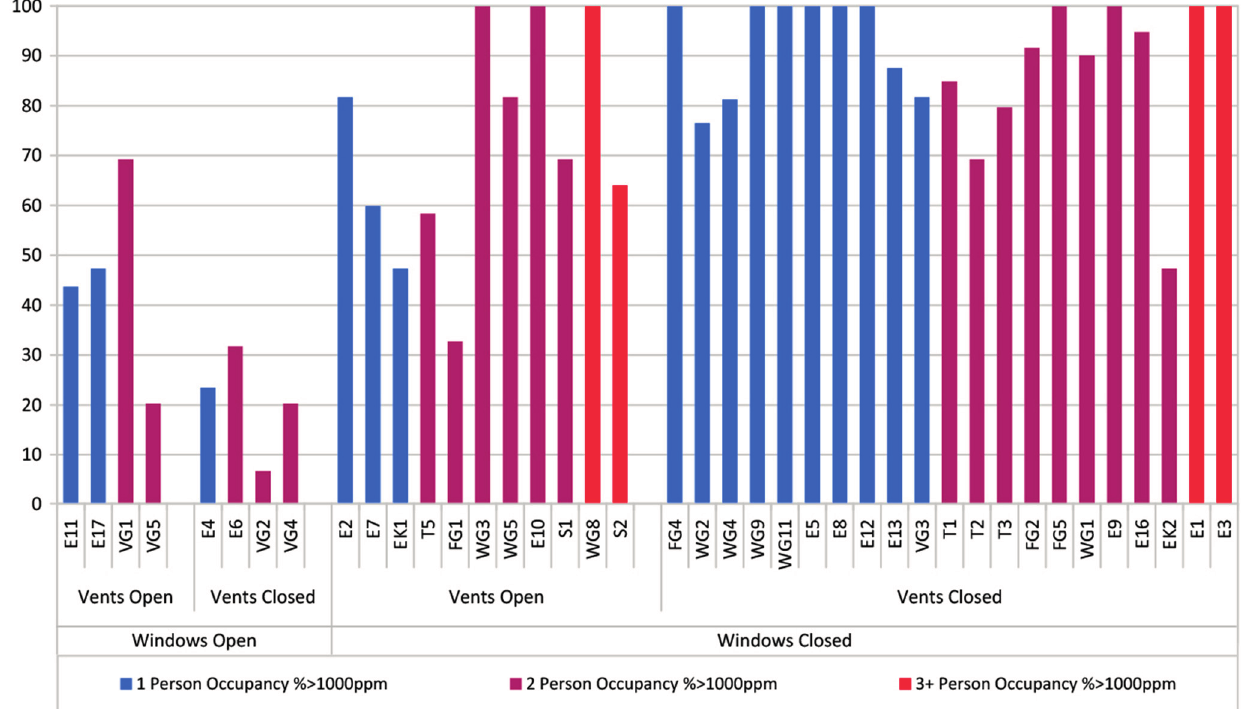
Figure 6. Percentage of time bedroom CO 2 levels exceed 1000 ppm between 11 pm and 7 am across all of the 40 monitored